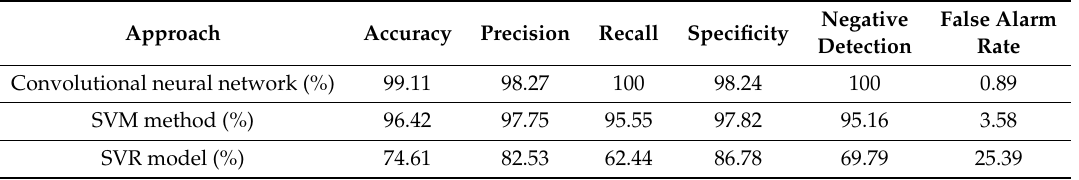
Table 32. Comparison of detection evaluation indices among the three methods for pitch system